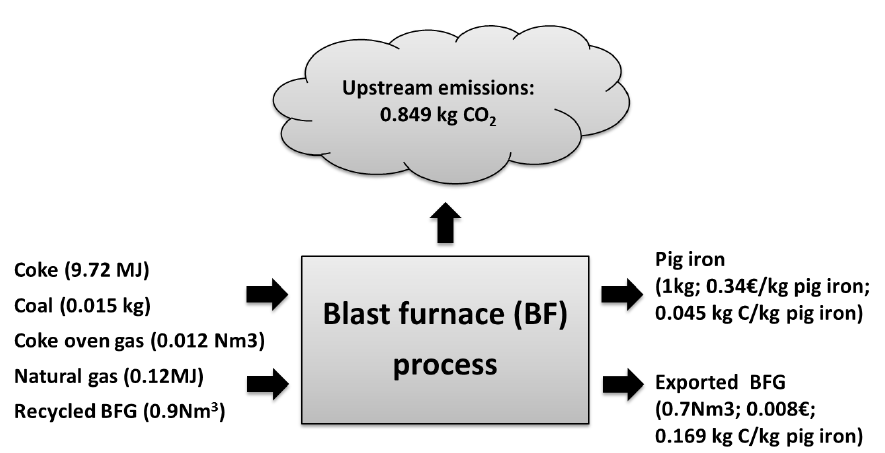
Figure 3. The balance of a blast furnace